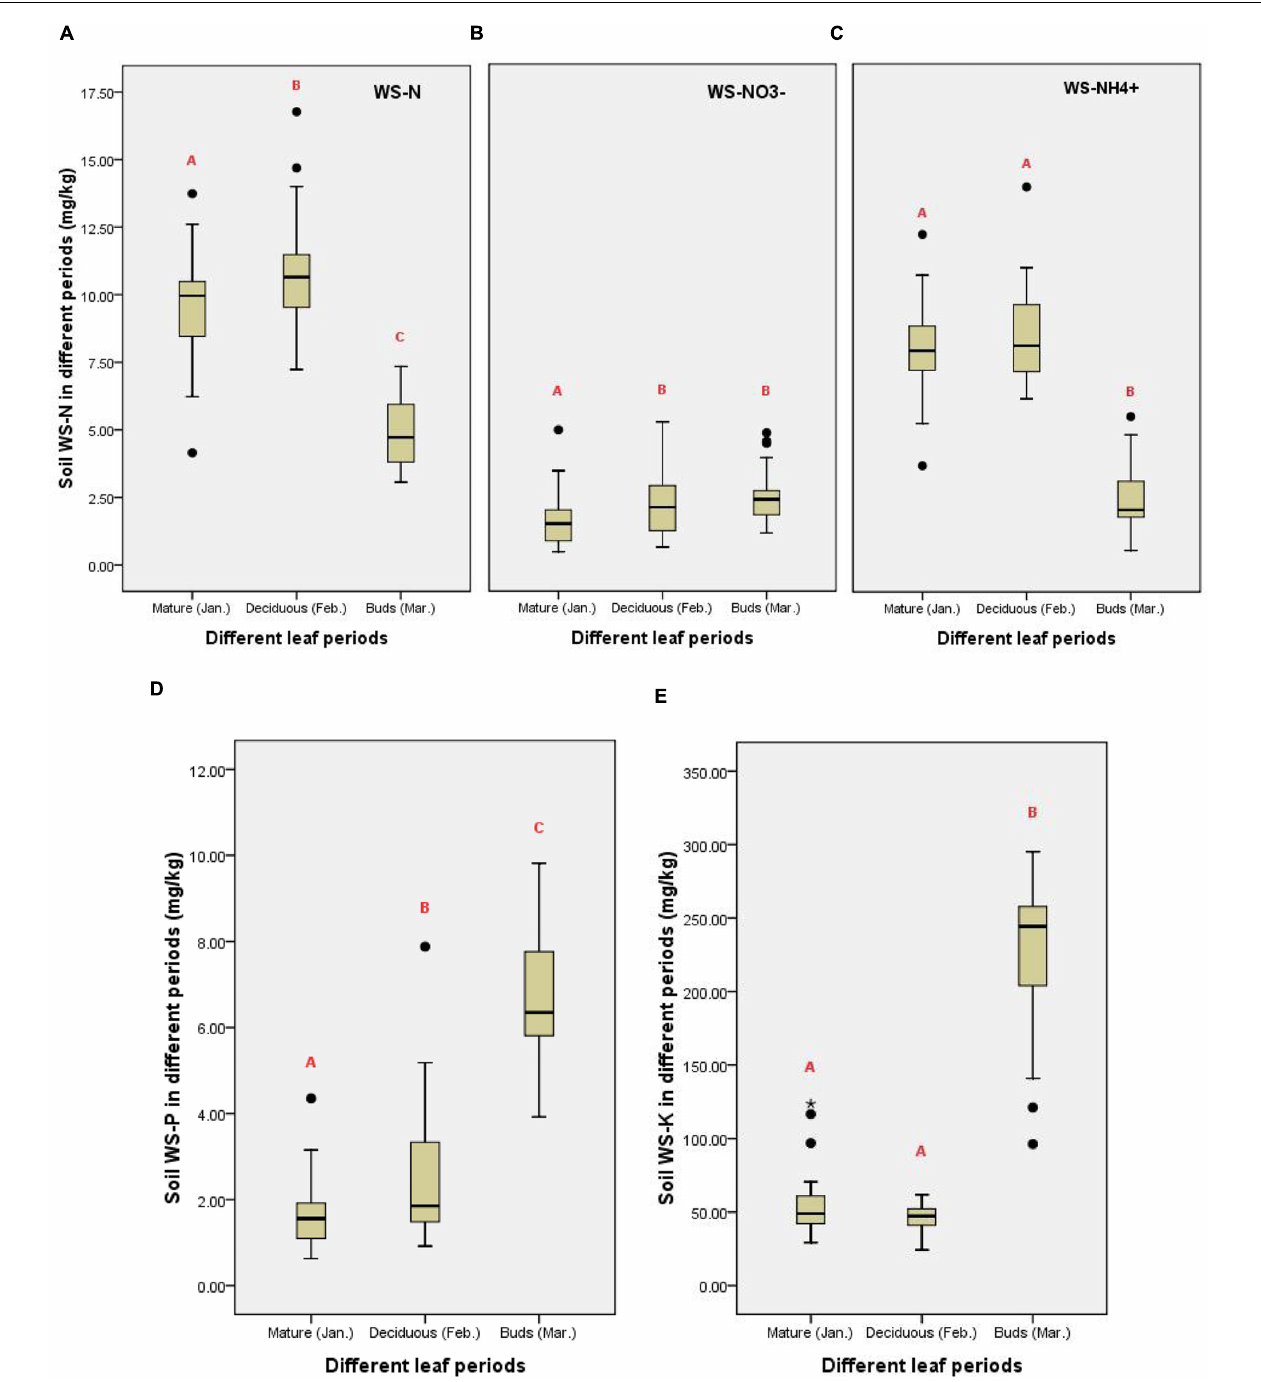
FIGURE 3 | Average soil total nitrogen (TN) (A–C) , total phosphorus (TP) (D) , and total potassium (TK) (E) during different leaf periods (Significant differences between different red alphabet “A, B, and C”).